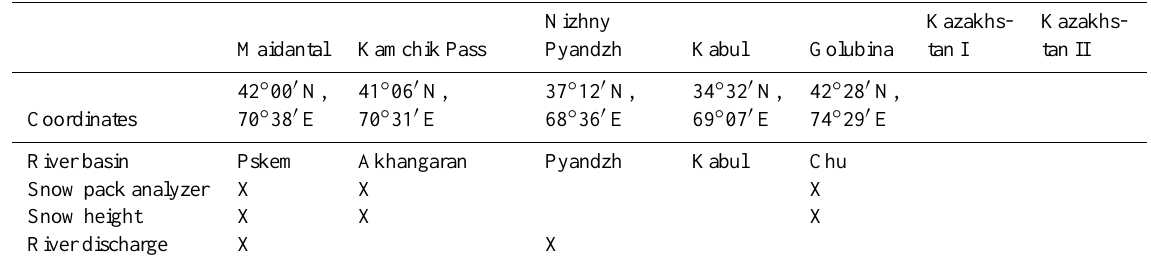
Table 6. Station installations planned for 2013. All stations will be equipped with standard hydrometeorological sensors and